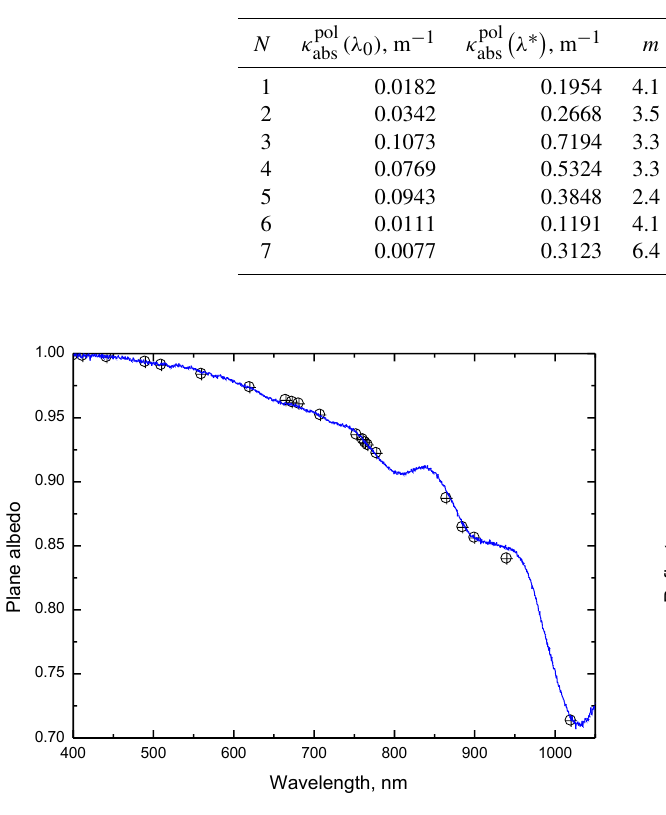
Figure 4. The intercomparison of theory (symbols) with experi- mental measurements (line) in the European Alps (45 ◦ 55 (cid:48) 56 . 70 (cid:48)(cid:48) N, 9 ◦ 31 (cid:48) 33 . 28 (cid:48)(cid:48) E) for the polluted snowpack. The parameters R 0 , l , f and m have been derived from the measurements at 400, 560, 865 and 1020nm. Reflectance measurements were collected on snow containing different concentration of dust: 39.6ppm (black line) and 107.4ppm (red line). The dust has been collected from the upper snow layer ( ≈ 5cm). Snow was clean at larger depths. A complete description of this dataset is presented in Di Mauro et al.